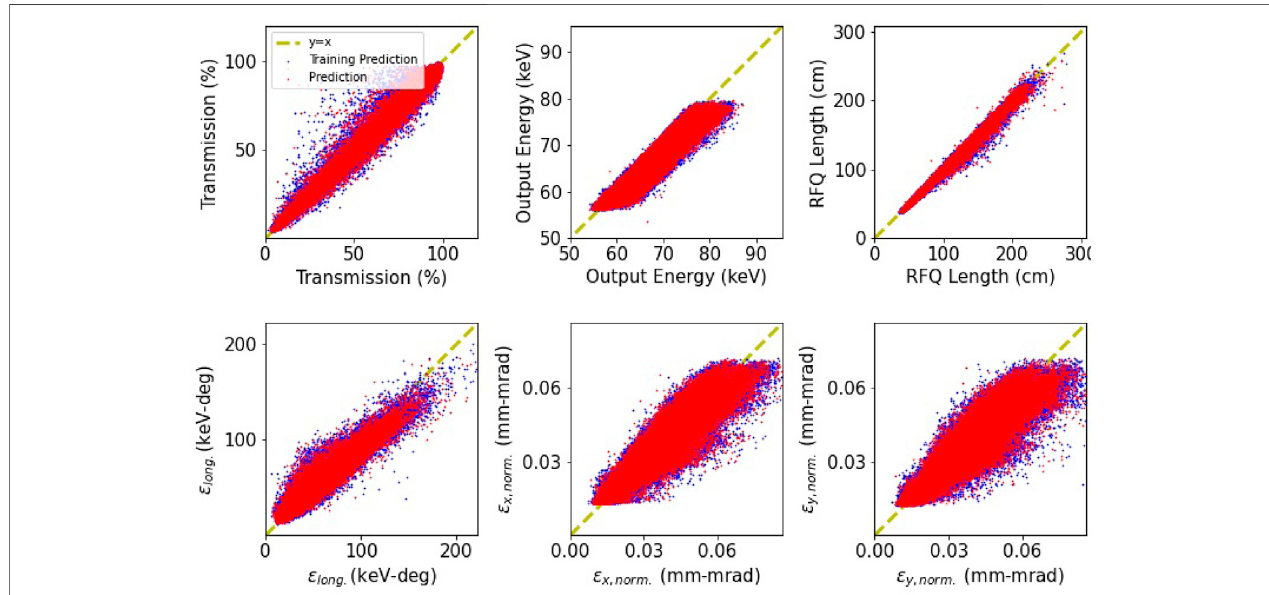
FIGURE 6 | Surrogate model predictions as function of the actual data values for full RFQ design variation by 14 DVARs and fi xed beam input Twiss parameters. Again, the red dots correspond to the test dataset and the blue dots are training data.